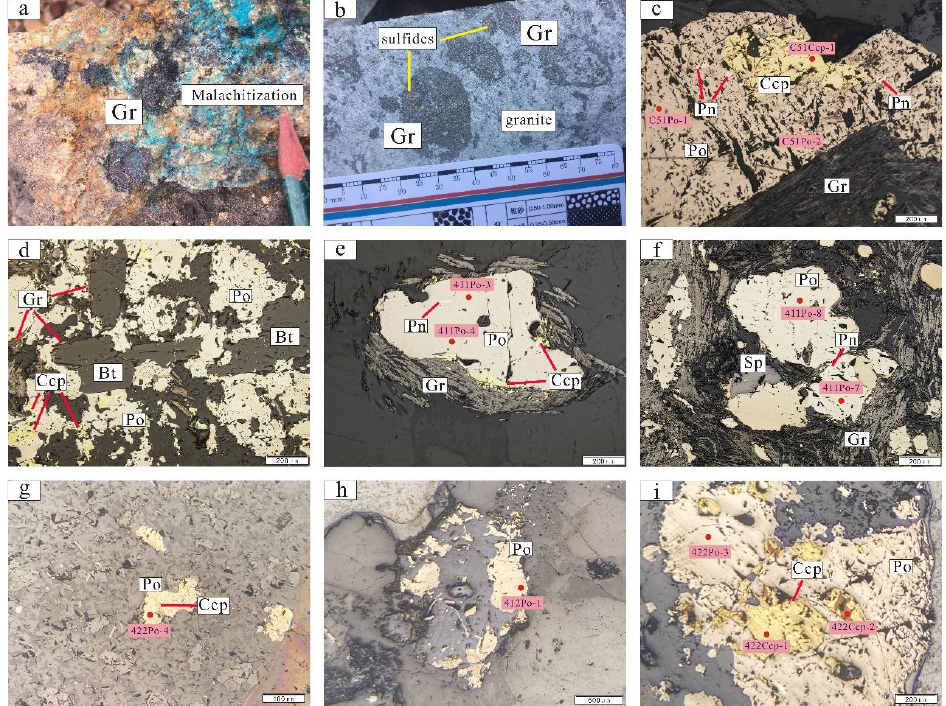
Figure 3. Characteristics and intergrowth of the graphite and metal sulfides in the orbicular graphite ore; ( a ) spherical graphite associated with malachitization on the surface; ( b ) metal sulfides sur- rounded by spherical and irregular graphite in drill holes; ( c ) nodular pyrrhotite containing chalco- pyrite and pentlandite in the graphite (reflected light); ( d ) coarse-grained pyrrhotite coexisted with euhedral biotite (reflected light); ( e ) flake graphite growing along the edge of granular pyrrhotite (reflected light); ( f ) xenomorphic granular light yellow and brown pyrrhotite (reflected light); ( g ) fine-grained xenomorphic pyrrhotite in the graphite orbicular ore (reflected light); ( h ) metasomatic structure of pyrrhotite and sphalerite (reflected light); ( i ) copper yellow and brown chalcopyrite in graphite orbicular ore (reflected light). Gr — graphite, Po — pyrrhotite, Ccp — chalcopyrite, Pn — pent- landite, Bt — biotite Sp — sphalerite.